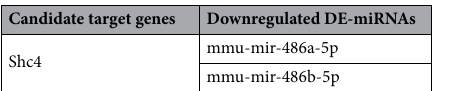
Table 3. Candidate target genes of the downregulated